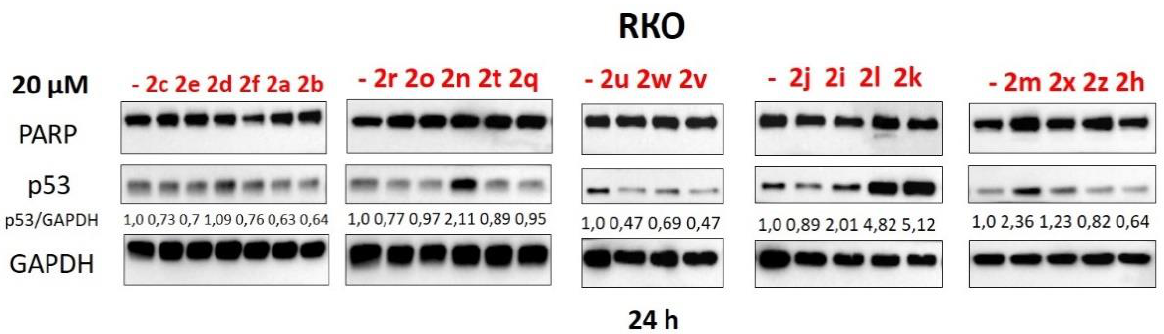
Figure 3. Western Blot analysis of total cellular lysates from RKO cells upon treatment with com- pounds: A ( 2a – 2f ), B ( 2n , 2o , 2q , 2r , 2t ), C ( 2u – 2w ), D ( 2i – 2l ), E ( 2h , 2m , 2x , 2z ). GAPDH was used as a loading control. The concentrations of all derivatives —20 μM. PARP— poly (ADP-ribose)-pol- ymerase; GAPDH — glyceraldehyde 3-phosphate dehydrogenase; p53/GAPDH — densitometric analysis of p53 bands normalized to GAPDH, h — hours.